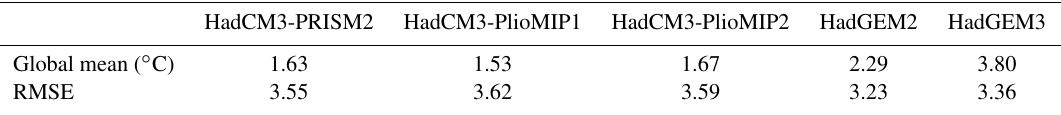
Table 3. Global annual mean SST anomalies from Pliocene simulations using different generations of the UK’s physical climate model and RMSE values between simulations and SST proxy data from McClymont et al.